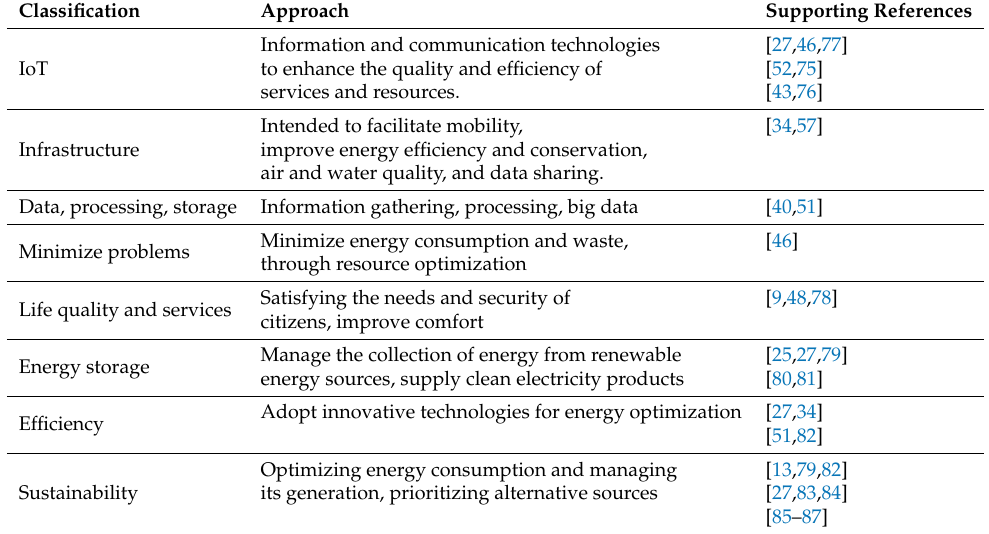
Table 1. Different approaches to Smart